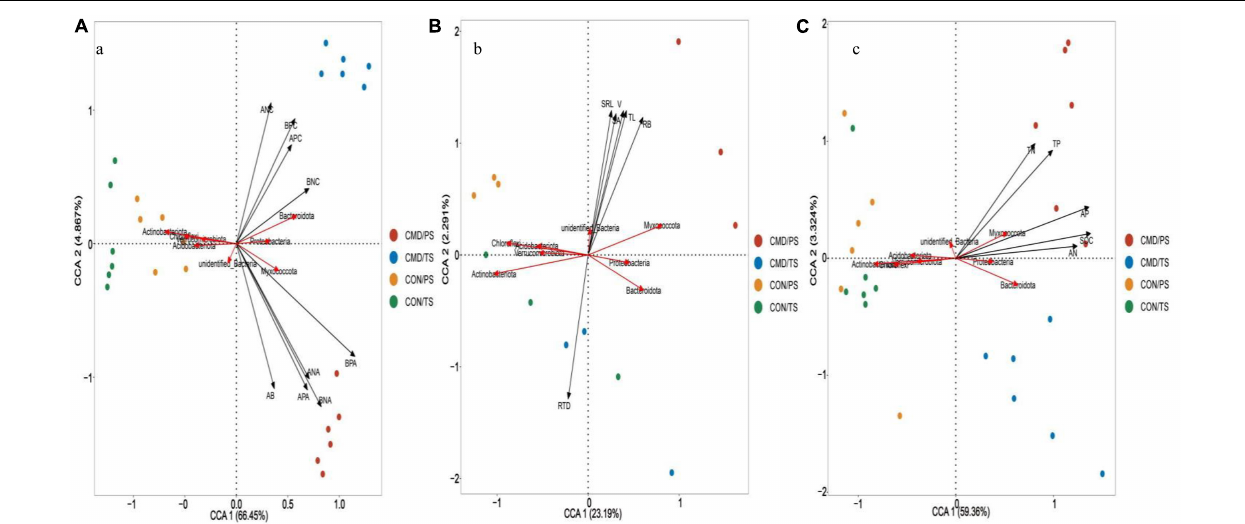
FIGURE 7 | Canonical correspondence analysis (CCA) showing bacterial community composition at phyla level as affected by biomass and nutrient absorption and return (A) , and root traits (B) soil chemical property (C) . Microbial community composition located in the forward direction of the arrow of the environmental factor implies positive relationship between the microbial community composition and the environmental factor, and vice versa. TS, plant trefoil stage (15 days after sowing); PS, plant pustulation stage (66 days after sowing); AB, aboveground biomass; RB, below-ground biomass; ANC, above-ground N content; BNC, below-ground N content; APC, above-ground P content; BPC, below-ground P content; ANA, above-ground N accumulation; BNA, below-ground N accumulation; APA, above-ground P accumulation; BPA, below-ground P accumulation. CON, control; CMD, cattle manure deposition. RL, Root length; SA, root surface area; V, root volume, SRL, specific length; RTD, root tissue density; SOC, soil organic carbon; TN, total nitrogen; AN, available nitrogen; TP, total phosphorus; AP, available phosphorus. Data represents mean ± SE (n = 3). The data was based on a pot experiment in one year. All parameters were analyzed with SPSS version 16.0 (SPSS Inc. Chicago, IL, United States).